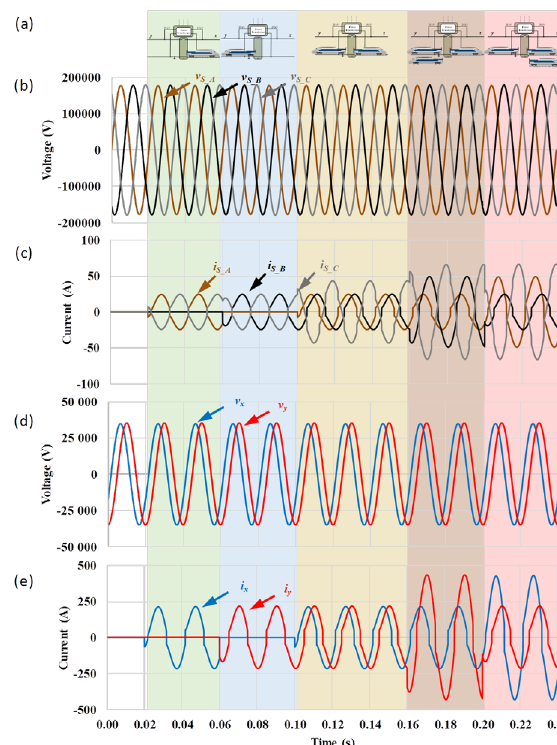
Figure 5. Simulation results of the railway system powered by a Scott power transformer: (a) Case scenarios with different number of locomotives in the catenaries; (b) Three- phase power grid voltages v S_A , v S _ B and v S_C ; (c) Three-phase power grid currents i S_A , i S _ B , i S_C ; (d) Voltage in the catenaries, v x and v y ; (e) Currents in the catenaries, i x and i y